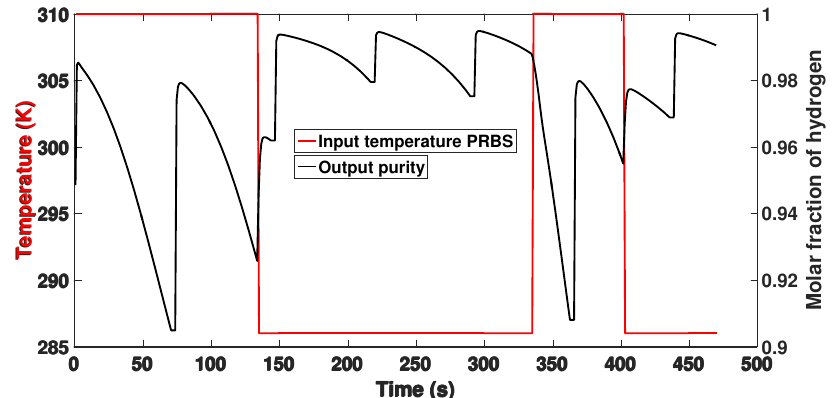
Figure 6. Input data (variable temperature) and output data (hydrogen purity).